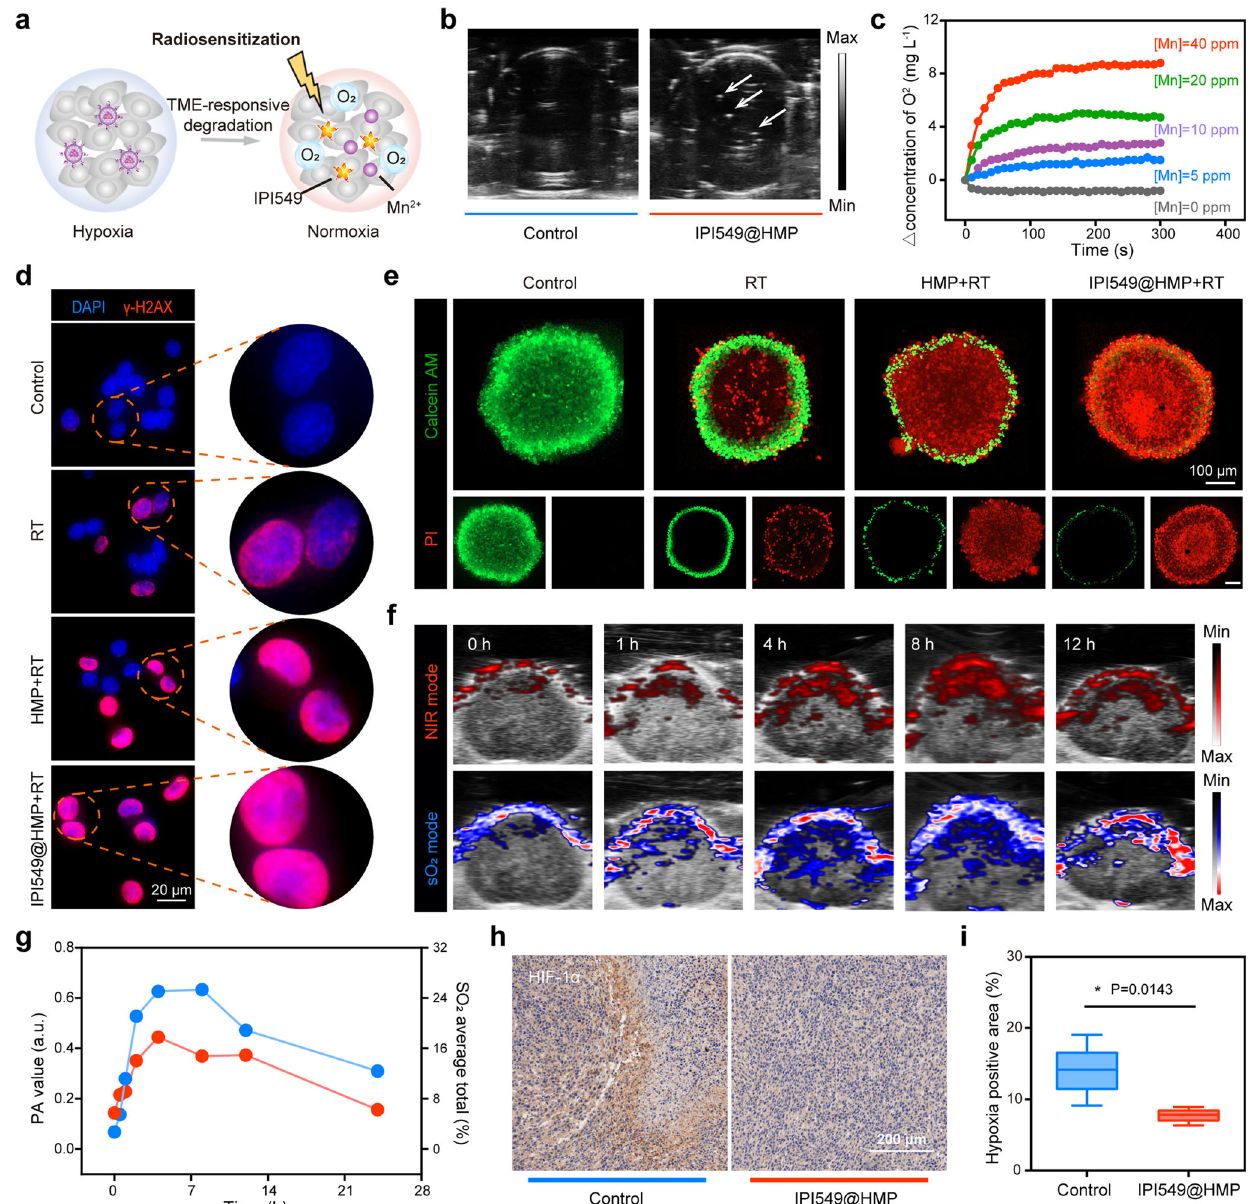
Fig. 4 IPI549@HMP-induced hypoxia remission for augmented RT. a Schematic illustration of IPI549@HMP for hypoxia-relieved RT. b